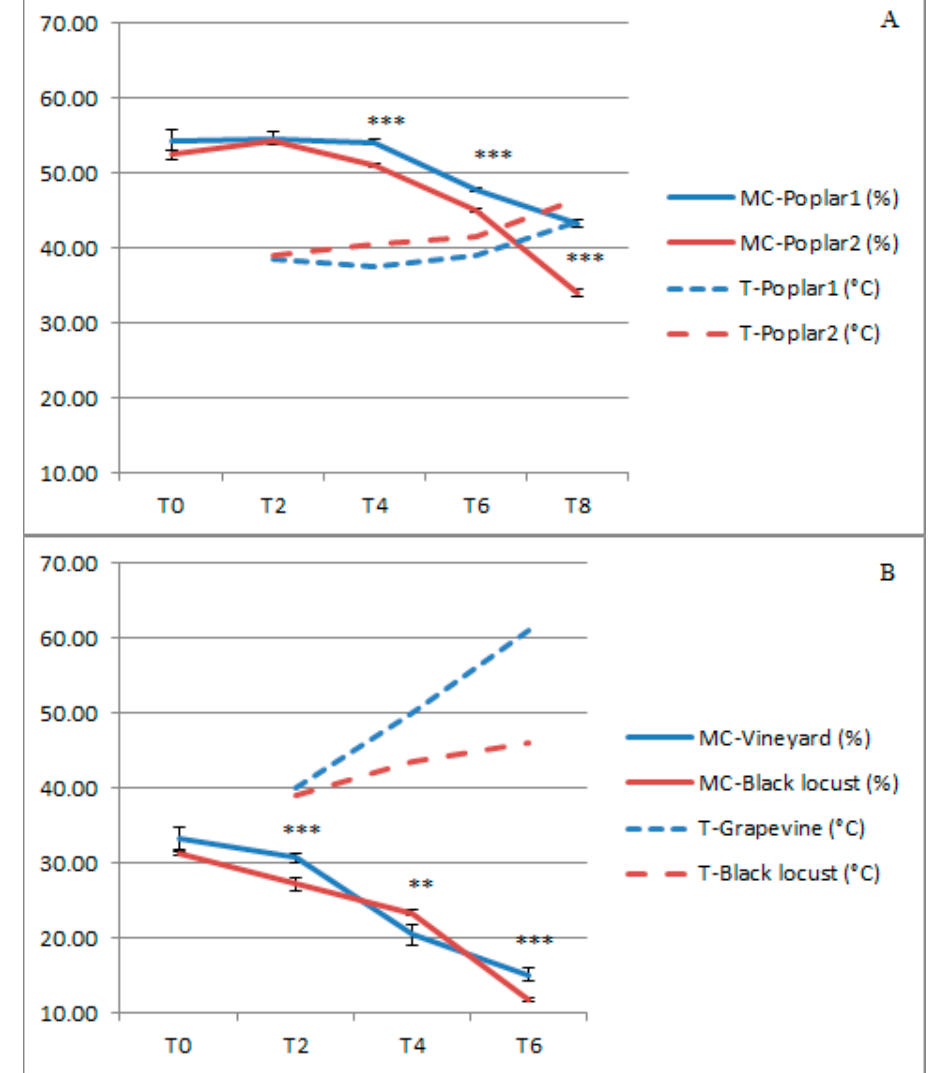
Figure 6. Mean ( ± SD) of the moisture content (MC, solid line) and the temperature (T, dotted line) inside the cylinder at each time-point of the drying cycle: ( A ) Poplar 1 and Poplar 2; ( B ) grapevine and black locust. For the moisture content, significant di ff erences between treatment within each time were determined by Student’s t -test. Where reported, ** P < 0.01 and *** P < 0.001 probability